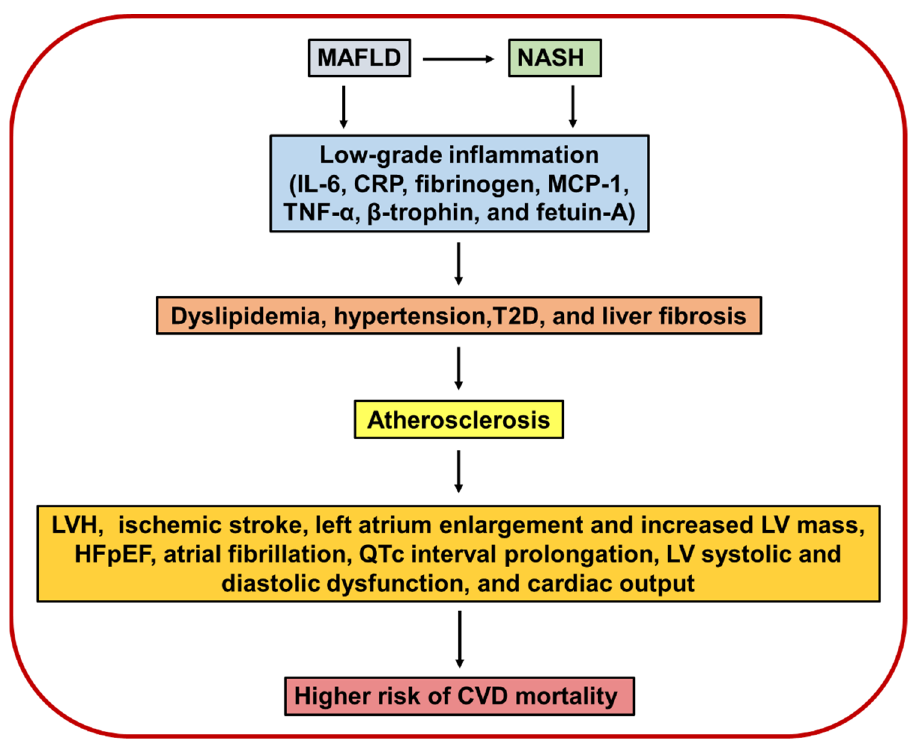
Figure 3. Cardiovascular adverse events associated with MAFLD and NASH. Systemic low-grade inflammation induced in MAFLD or NASH is linked with dyslipidemia, hypertension, T2D, and hepatic fibrosis, which may cause atherosclerosis and finally cardiovascular complications with higher risk of CDV mortality. Abbreviations: MAFLD, metabolic dysfunction-associated fatty liver disease; NASH, nonalcoholic steatohepatitis; IL-6, Interleukin-6; CRP, C-reactive protein; MCP-1, monocyte chemotactic protein 1; TNF- α , tumor necrosis factor- α ; T2D, type 2 diabetes; LVH, left ventricular hypertrophy; LV, left ventricular; HFpEF, HF with preserved ejection fraction; QTc, corrected QT interval; CVD, cardiovascular disease.